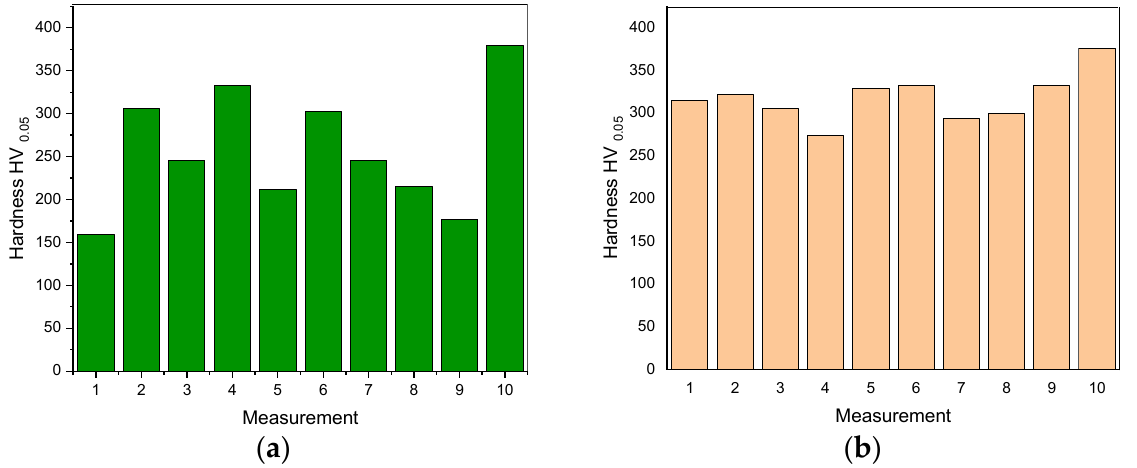
Figure 11. The microhardness results for ( a ) Mg–Zn–Ca–Au powder alloy after 13 h of milling and ( b ) Mg–Zn–Ca–Au sintered alloy.